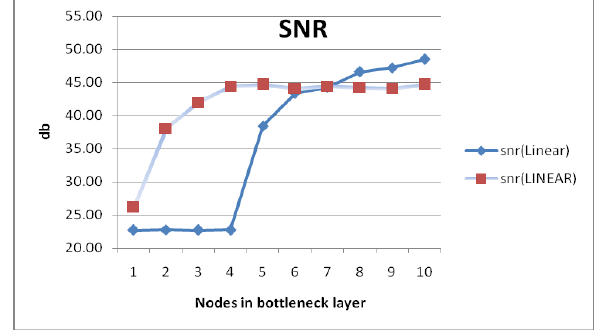
Figure 3. Distortion in terms of